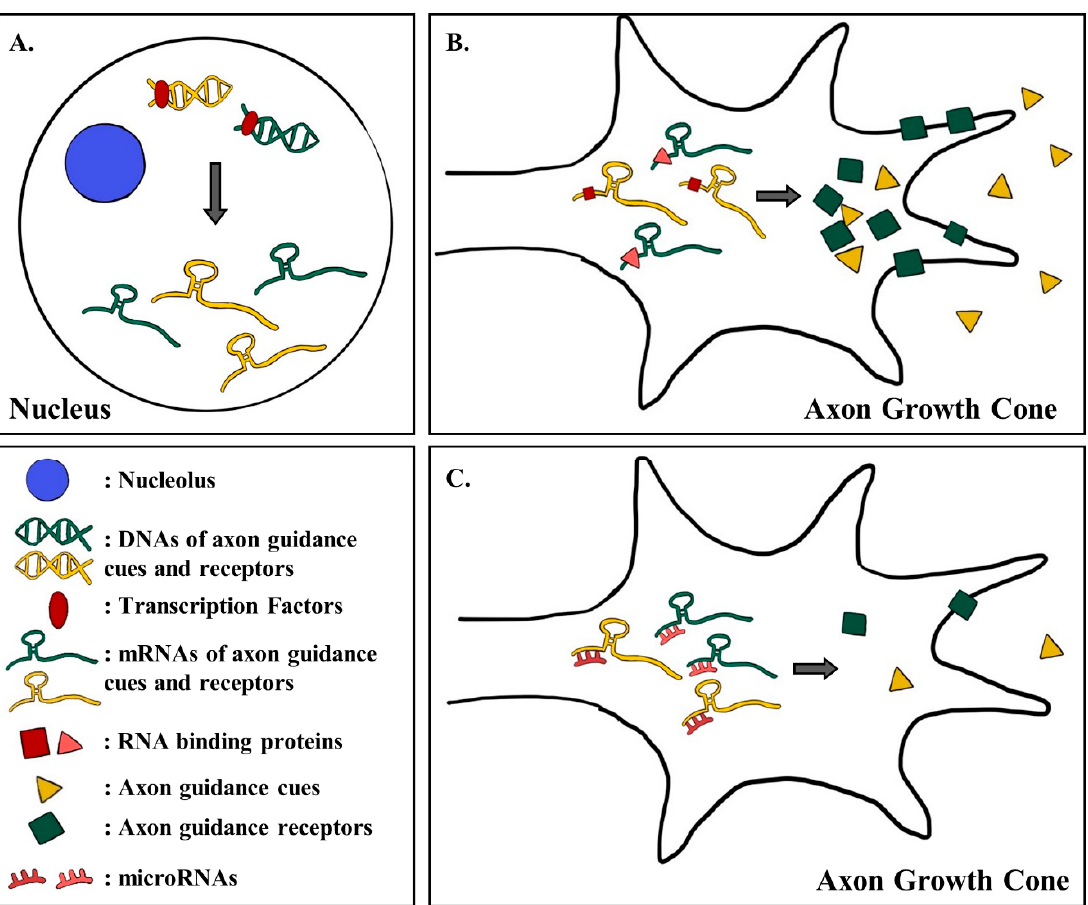
Figure 2. Transcriptional and post-transcriptional regulation of the expression of the guidance proteins and receptors. (A) The expression of the guidance cues and receptors are transcriptionally regulated. Different transcription factors bind to the promoter of guidance cues and receptors genes to either enhance or suppress their transcriptional activities. The gray arrow represents the transcription. (B) The expression of the guidance cues and receptors are also post-transcriptionally regulated. Different RNA binding proteins bind to the untranslated regions (UTR, 3 ′ UTR and 5 ′ UTR) of the guidance cues and receptors mRNAs to regulate their translational activity or the stability. The gray arrow represents the translation. (C) MicroRNAs (miRNAs) can also regulate the expression of guidance cues and receptors post-transcriptionally. Different miRNAs bind to the specific miRNA recognition element (MRE) on the mRNAs of guidance cues and receptors to modulate their translational activity or the stability. The gray arrow represents the translation.